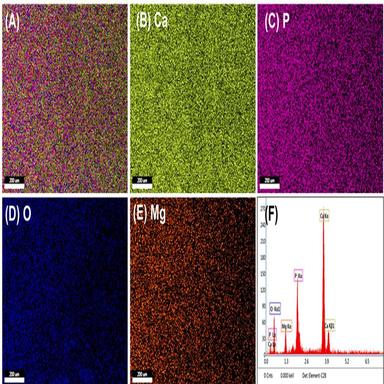
(A)–(E) Energy-dispersive X-ray spectroscopy (EDX) mappings of the as-synthesized Mg-doped hydroxyapatite nanofibers (Mg.HAPNFs). (F) EDX profile of Mg.HAPNFs.